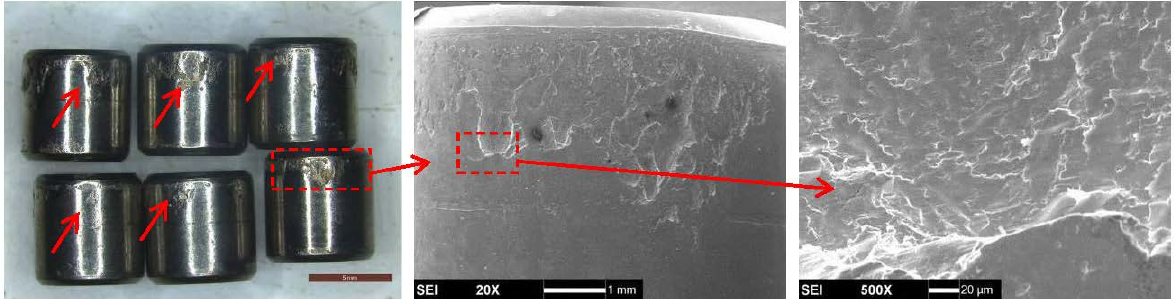
Figure 10. Surface damages of the rollers.